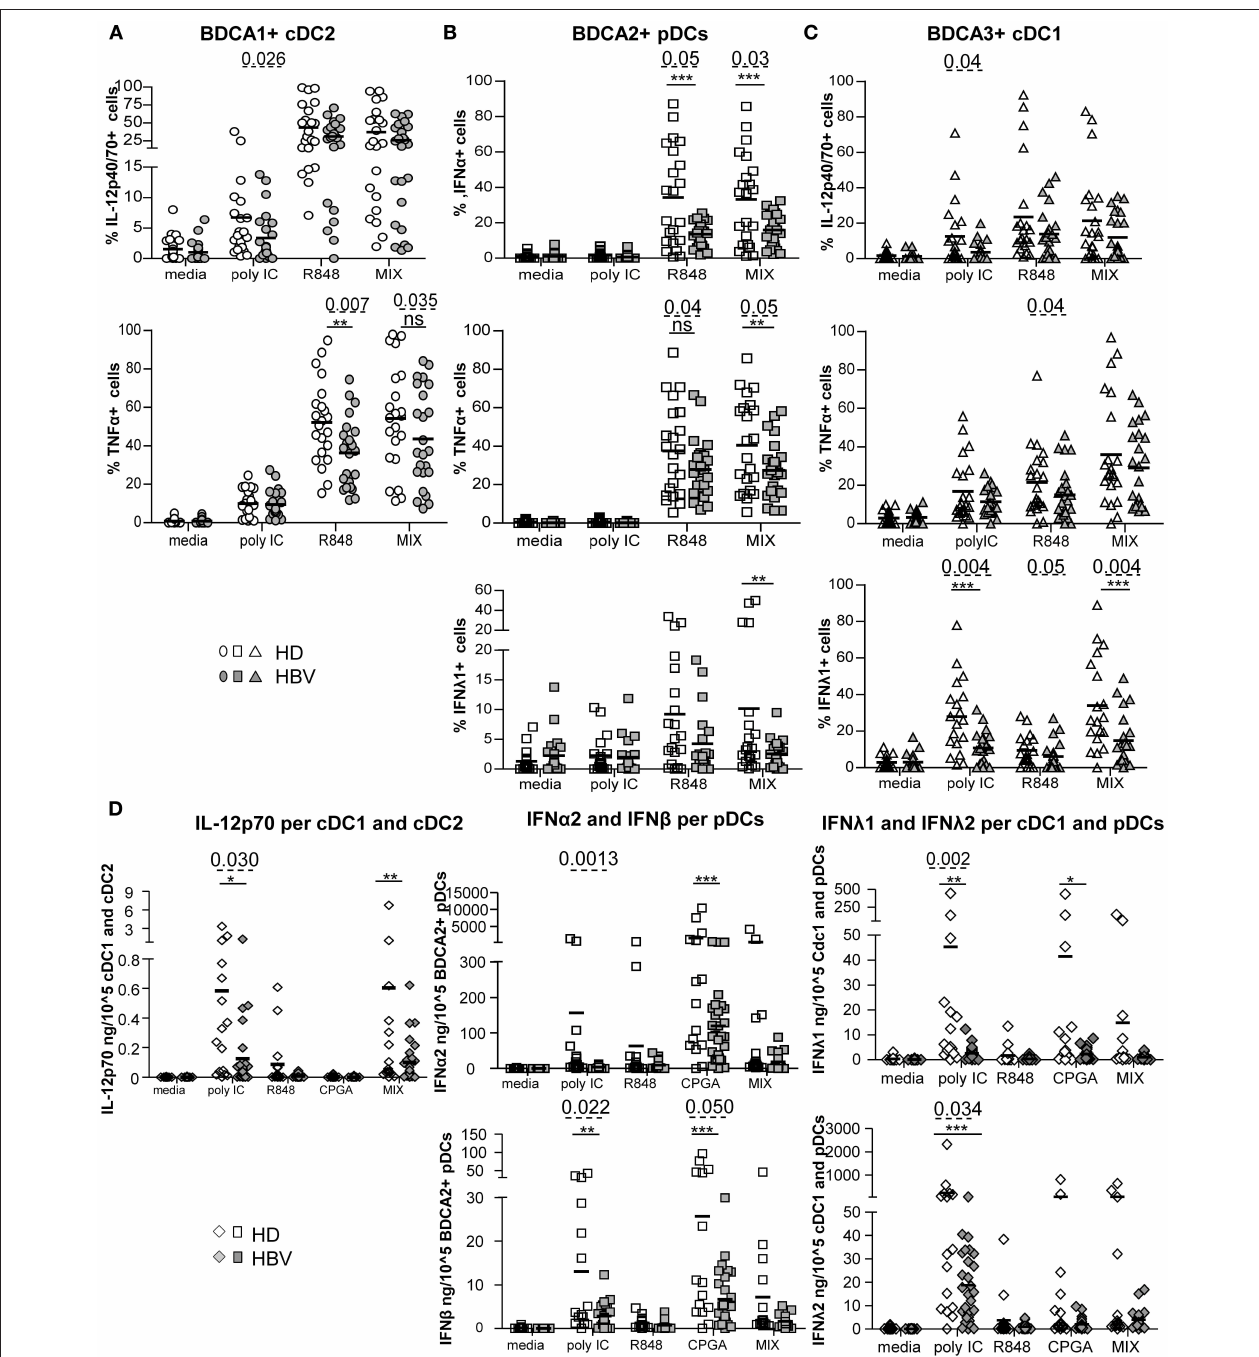
FIGURE 6 | Impairment of intracellular IL-12p70, TNF α , IFN α , and IFN λ 1 (IL-29) production by blood DC subsets from chronic HBV patients upon TLR triggering. Whole blood samples were stimulated for 5-h with or without polyI:C, R848, CPG A (ODN2336) alone or mixed together (MIX:polyI:C + R848 + CPG A ) and the production of cytokines by each DC subset was measured by intracellular staining by flow cytometry. Percentages of cytokine-expressing cells within (A) cDC2, (B) pDCs, and (C) cDC1. Open symbols, HD ( n = 20–24); filled symbols, HBV ( n = 20–26). (D) Cytokine’s secretion by PBMCs were reported to the absolute number of DCs present in sample before stimulation with TLRLs by calculating the cytokine production per DC subsets in each sample (amount of cytokine/10 5 DCs) for cDC2 + cDC1 (IL-12p70), pDCs (IFN α 2, IFN β ) and cDC1 + pDCs (IFN λ 1, IFN λ 2). Results are expressed in ng or pg/10 5 DC subsets. Open symbols, HD ( n = 20–24); filled symbols, HBV patients ( n = 20–26). P -values were calculated using the 2-way-RM ANOVA test (straight line) * P ≤ 0.05, ** P < 0.01, *** P ≤ 0.001; and the Mann–Whitney test (dashed lines).